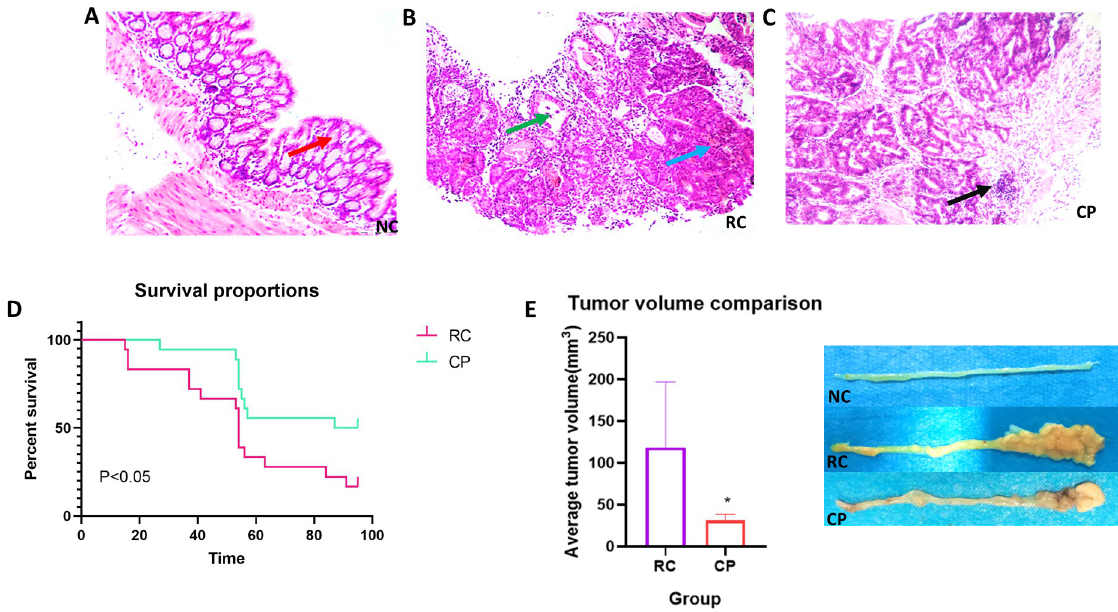
Fig 2. Effect of the probiotic powder on colorectal cancer. (A, B, C) Hematoxylin and eosin (HE) staining of the NC, RC, and CP groups, respectively ( × 400). Mouse colorectal tissue was obtained at the 13th week, and the histological changes of mouse colorectal tissues were analyzed using HE. The arrows represent important tissue damage. The red arrow represents normal goblet cells, the green arrow represents crypt abscess, the blue arrow represents inflammatory necrosis, and the black arrow represents inflammatory cell infiltration. ( D ) Survival rate of mice. The death of mice was recorded every day from initiation of the mouse model, and survival curves were generated through the 90th day. ( E ) Tumor volume of mice. The minimum and maximum diameters of tumors on each colorectal tissue sample were measured using Vernier calipers, and the volume of each tumor and the average tumor volume of each mouse were calculated. The tumor volume was 0.5 × the minimum diameter of the tumor × the square of the maximum diameter of the tumor. One way analysis of variance (ANOVA), � p < 0 . 05 .